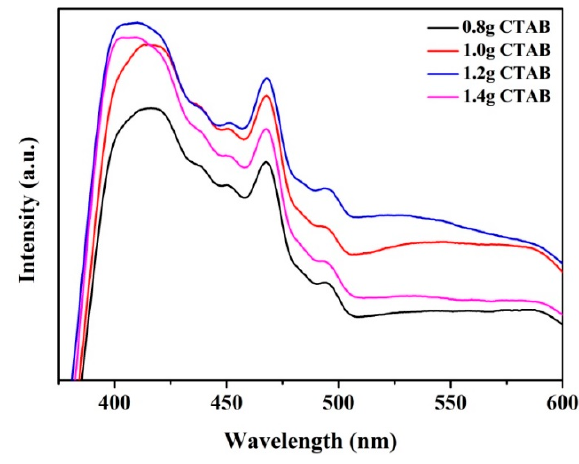
Figure 7. PL spectra for as-prepared ZnO particles arrays at room temperature.